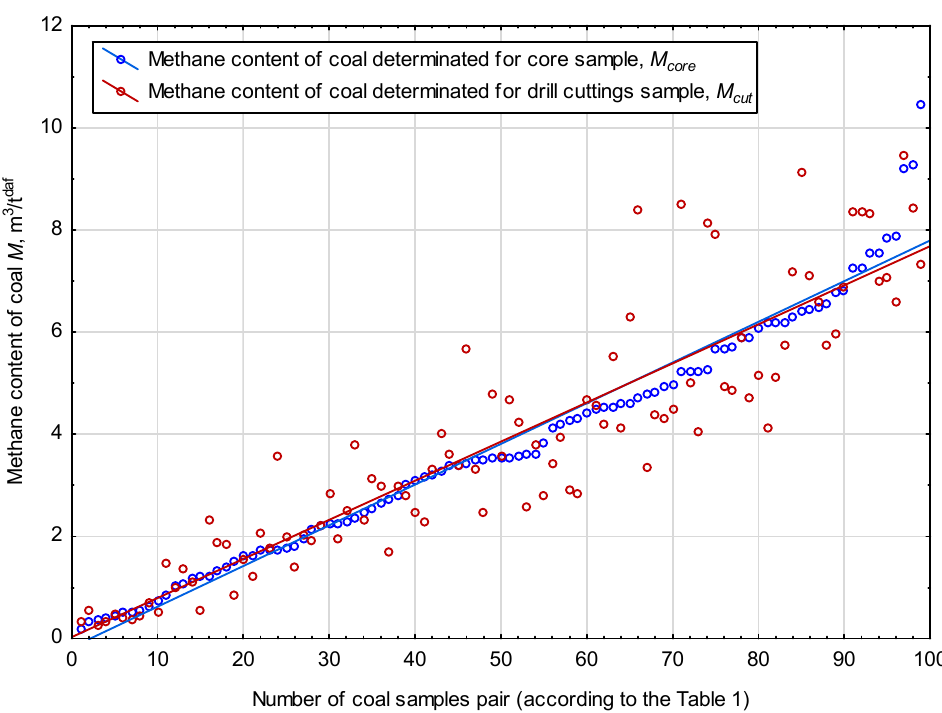
Figure 6. Distribution of the determined methane content of coal.